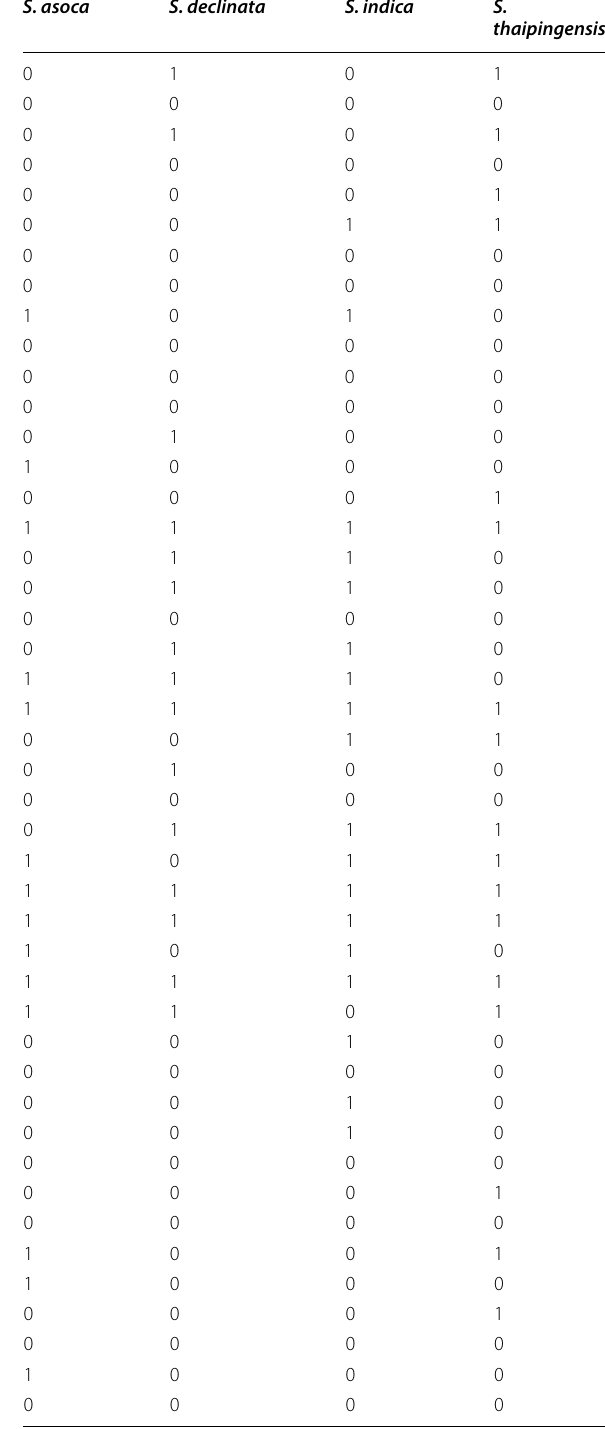
Table 3 Binary codes representing the presence and absence of traces of standards in different